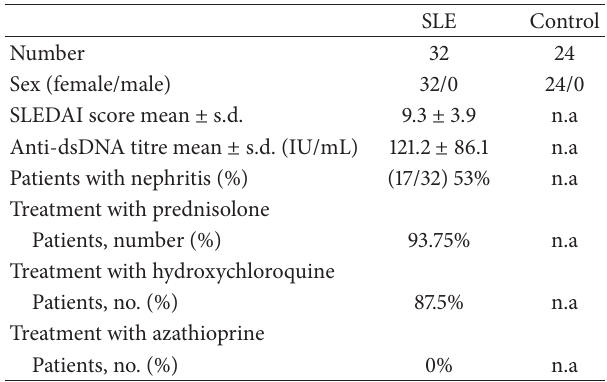
Table 1: Characteristics of systemic lupus erythematosus (SLE) patients and control